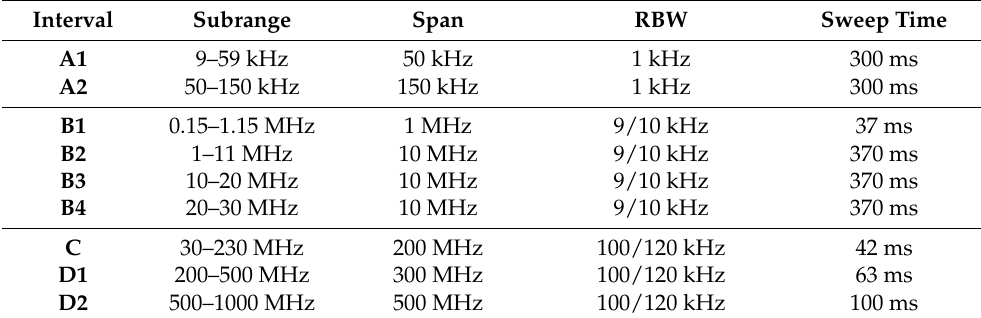
Table 1. Subdivision in frequency sub-ranges and advised sweep time values of EN